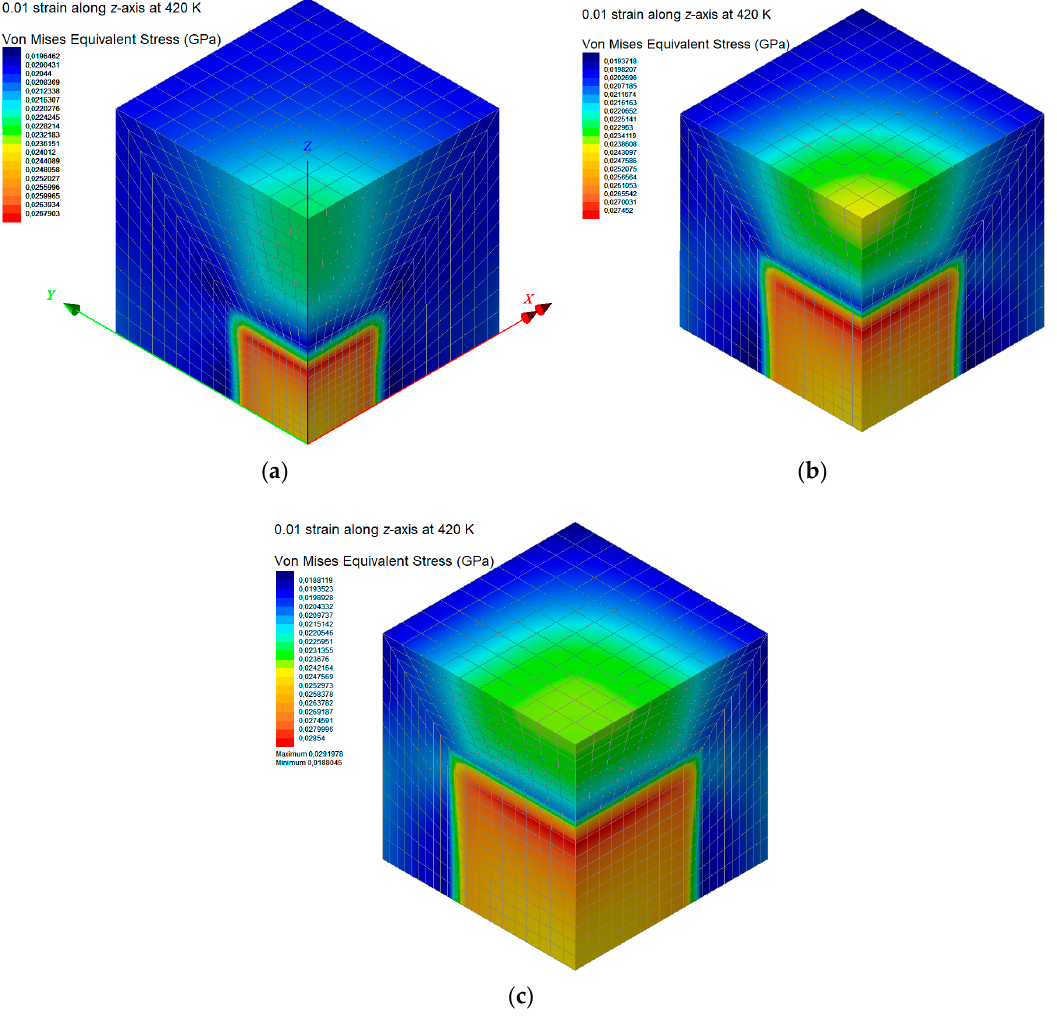
Figure 13. Contours of the resultant von Mises equivalent stress of the nanocomposite RVE at a temperature of 400 K, with mass fractions of ( a ) w C240 = 0.01, ( b ) w C240 = 0.03, and ( c ) w C240 = 0.05.